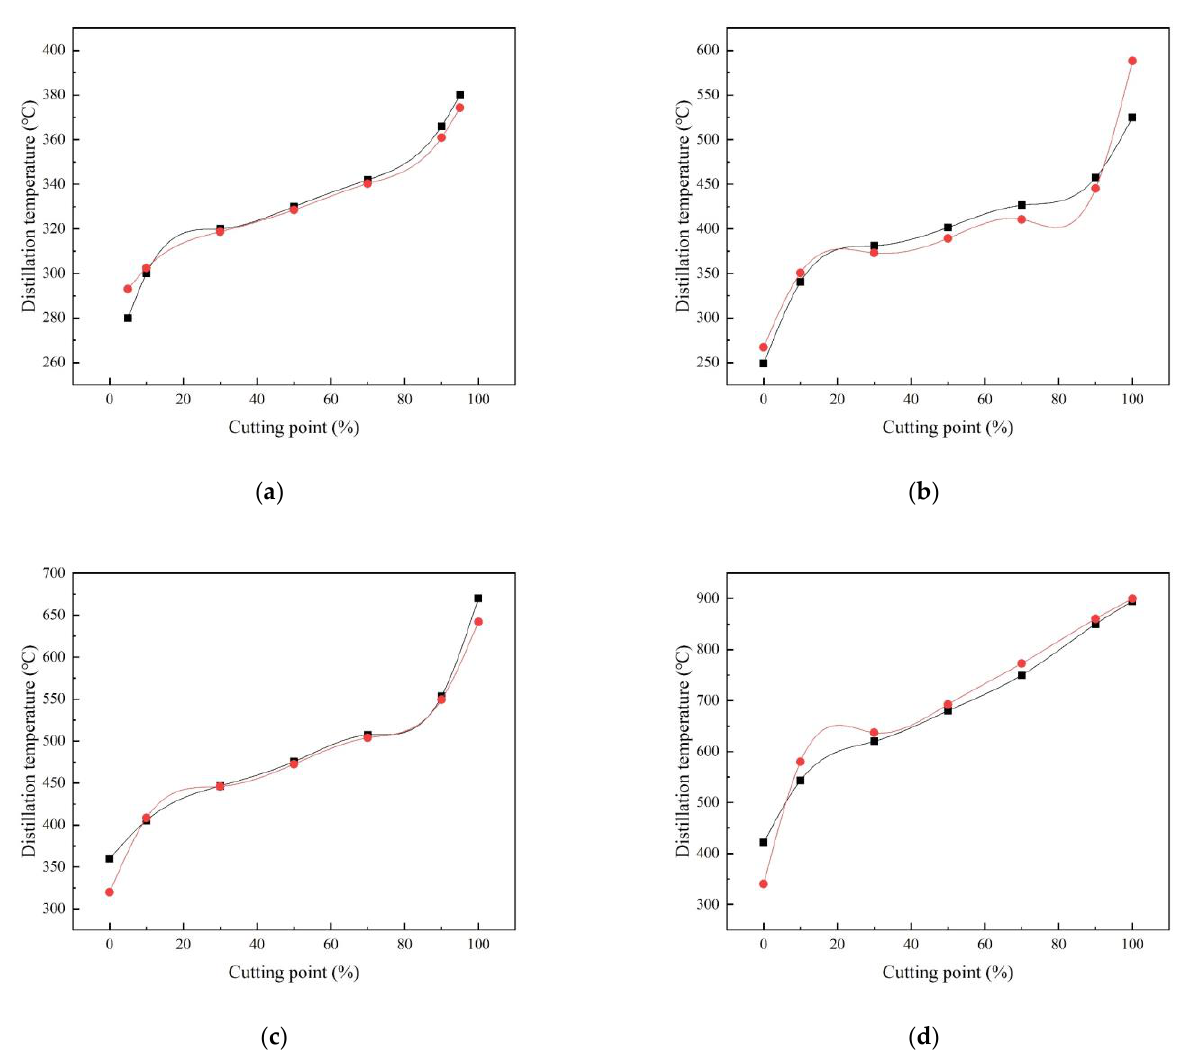
Figure 9. Comparison of D86 or D1160 distillation data of the main products of the rigorous model. ( a ) D86 distillation data of VDO; ( b ) D1160 distillation data of LVGO; ( c ) D1160 distillation data of HVGO; ( d ) D1160 distillation data of VR.